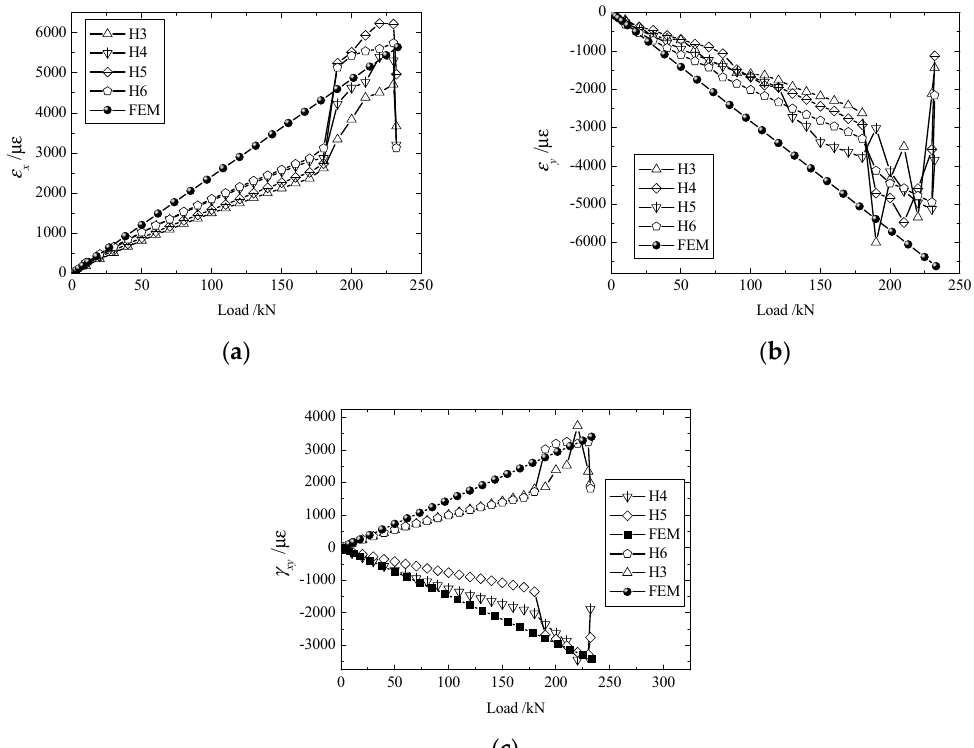
Figure 7. Load-strain curves of H2 and H7: ( a ) x